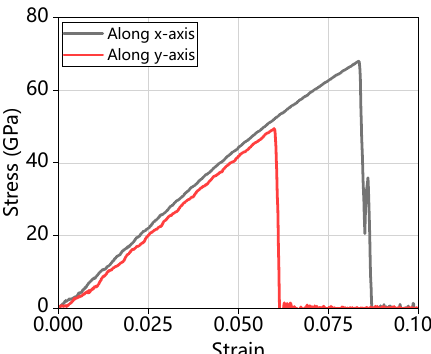
Figure 5. The stress–strain curve of bilayer graphene with different orientations of the rectangular cracks (l = 10 Å). Table 1. Rectangular cracks with different orientations (l = 10 Å).